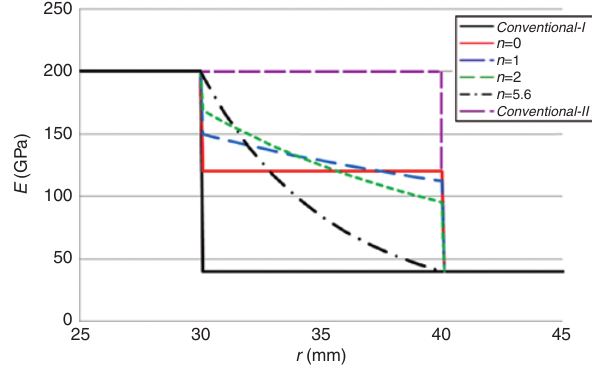
Figure 6: Non-dimensional radial stress of the conventional joint under axi-symmetric loading in analytical and finite-element method